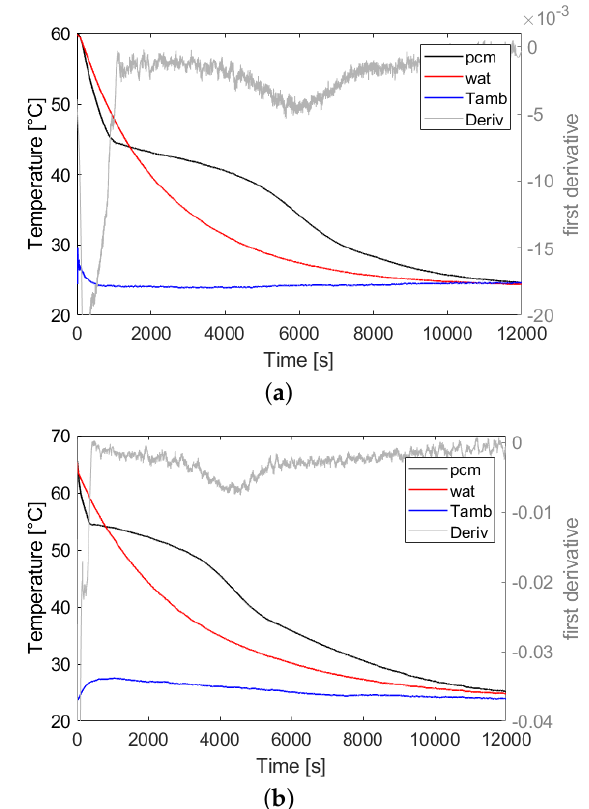
Figure 8. Resulting cooling curves ( a ) RT45; and ( b ) RT55. pcm: Sample of PCM. wat: reference test tube (water). Tamb: ambient temperature: Deriv: numerical derivative of sample temperature. Ten samples of each PCM tested were made and results are condensed in Tables 2 and